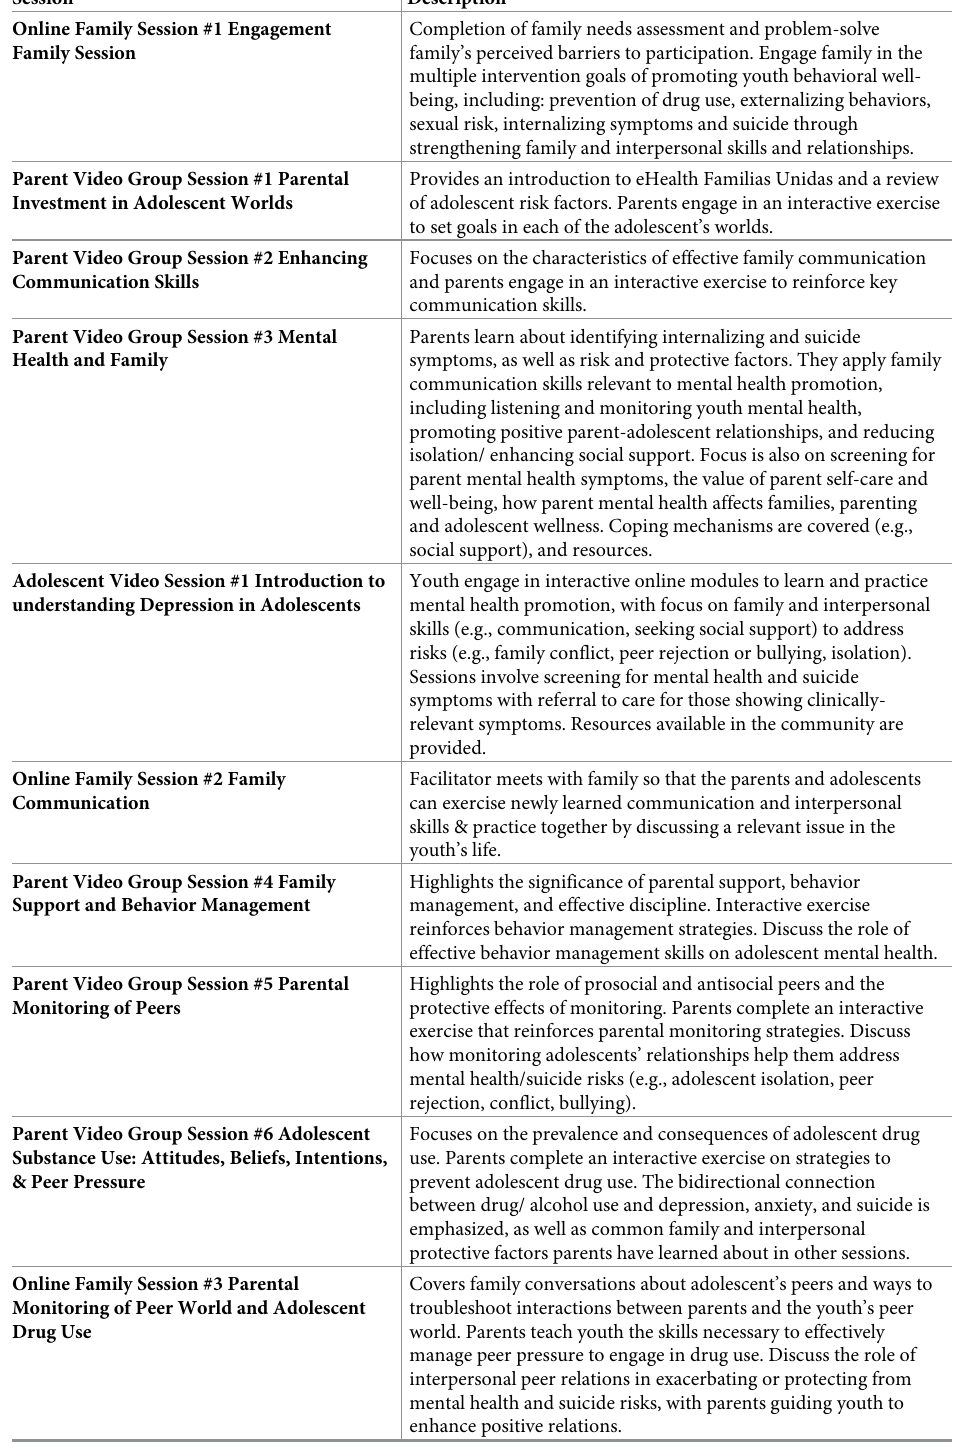
Table 1. eHealth Familias Unidas Mental Health–Session by session